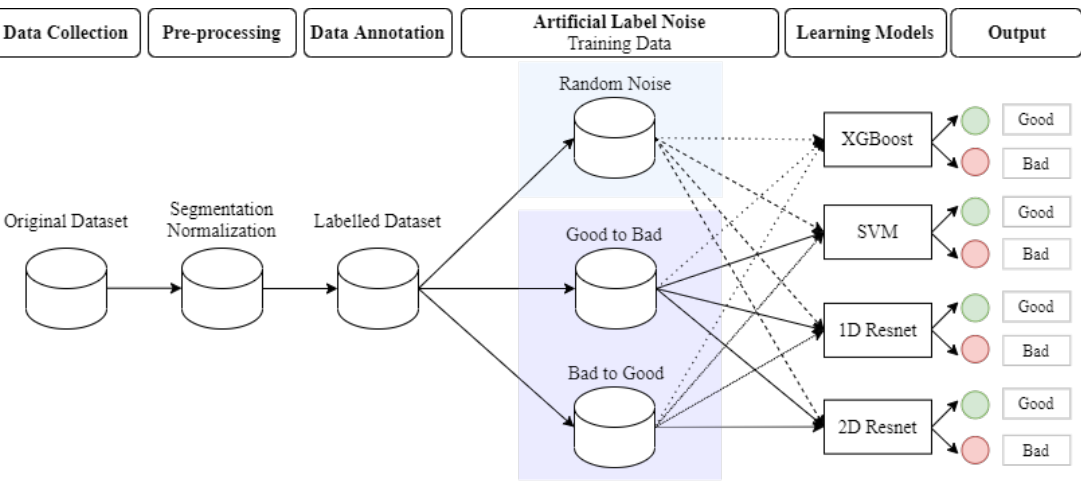
Figure 1. Overview of the pipeline of this study. Starting with data collection, followed by the an- notation process of the quality assessment for each PPG segment and the experiments for the artifi- cial label noise and the three learning models used in this study. The final output of the three learn- ing models was analyzed and the results were